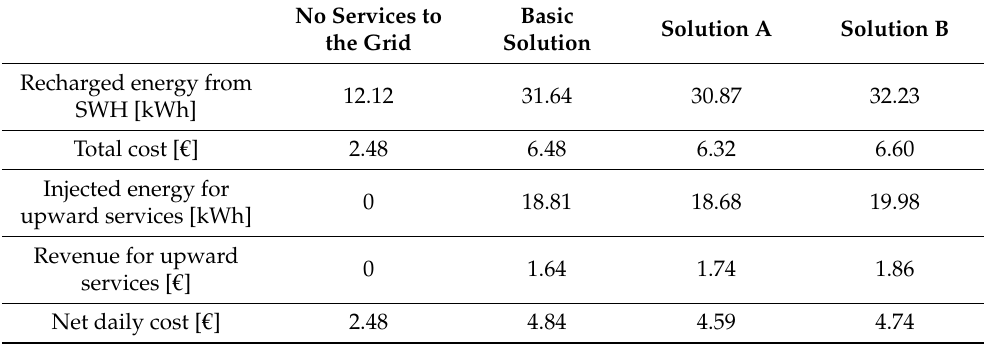
Table 14. Summary of costs and revenues for the analyzed solutions—mobility pattern 1.